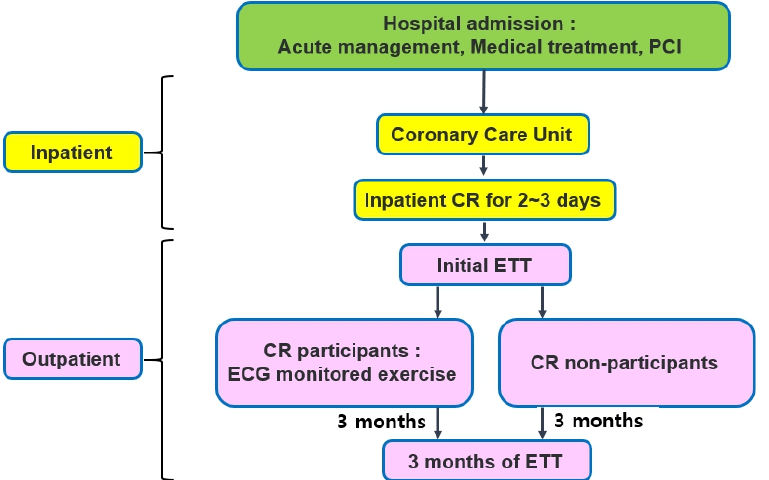
Figure 1. Study design. Abbreviations: CR, cardiac rehabilitation; PCI, percutaneous coronary intervention; ETT, exercise tolerance test; ECG, electrocardiography.